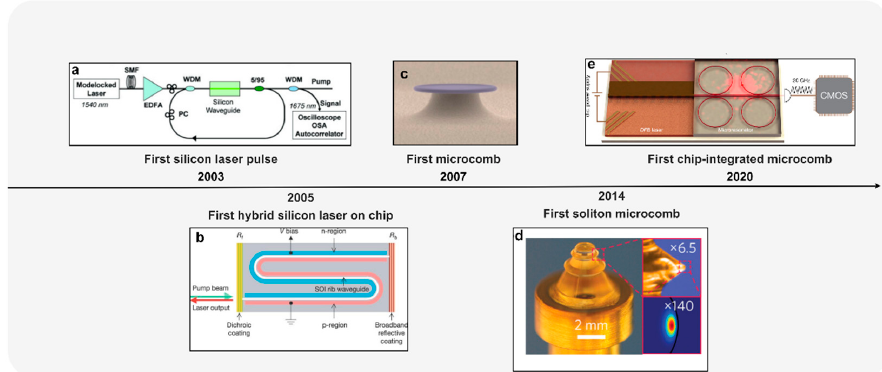
Figure 4. The development history of microcombs and some significant events. ( a ) Reprinted with permission from Ref [40], ©2004 Optica Publishing Group. ( b ) Reprinted with permission from Ref [42], Copyright © 2005, Springer Nature Limited. ( c ) Reprinted with permission from Ref [43]. Copy- right © 2007, Nature Publishing Group. ( d ) Reprinted with permission from [44]. Copyright © 2019, Springer Nature Limited. ( e ) Reprinted with permission from [45]. Copyright © 2020, Springer Nature